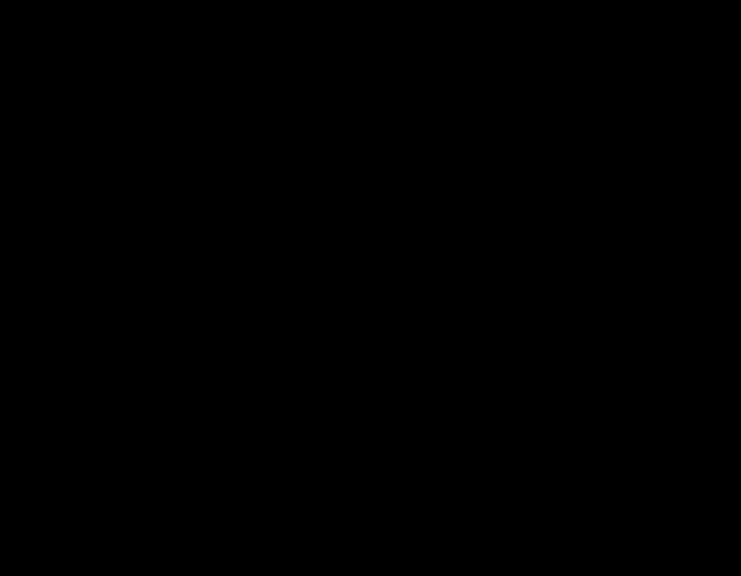
Management of disease persistence or recurrence following primary renal tumor ablation.